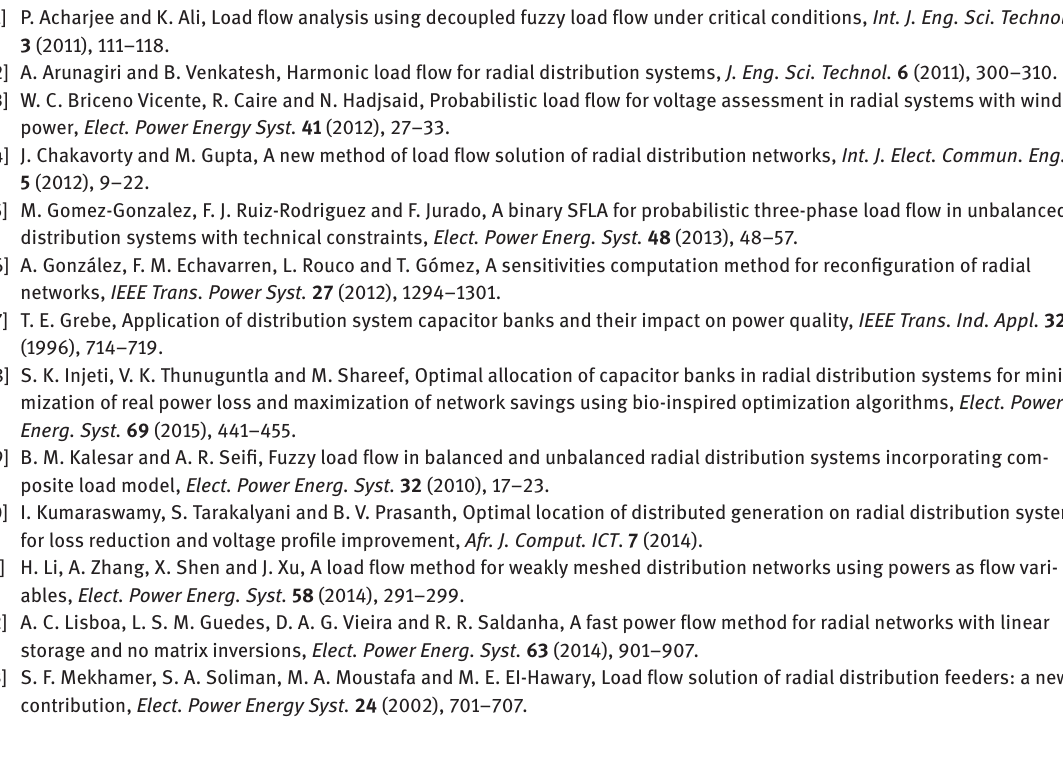
flow parameters like power loss and real and reactive power flow were evaluated. The total power loss and voltage deviations were analyzed, and the corresponding results were discussed. The deviation voltage was analyzed with the BW/FW sweep method and GA-based BW/FW sweep technique, which proved that the pro- posed method achieved better outputs. From the comparison results, it was shown that the proposed method is a sound and effective load flow technique for the radial distribution system, which is competent compared with other techniques.